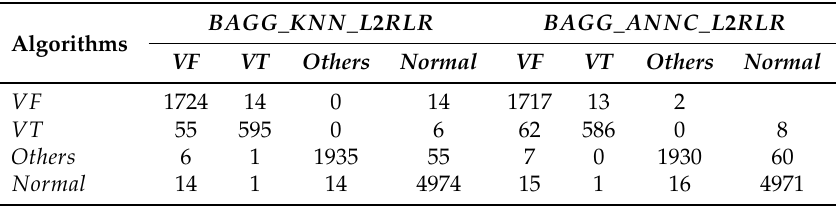
Table 8. Confusion matrix for classification of VF , VT , Others , and Normal classes using